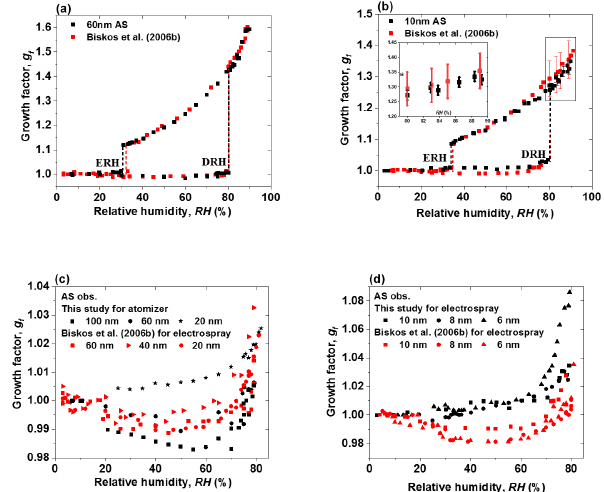
Figure 8. (a–b) Mobility diameter hygroscopic growth factors ( g f ; black squares), deliquescence and efflorescence relative humidity (DRH and ERH; black dashed lines) of ammonium sulfate (AS) nanoparticles with a dry diameter of 60 and 10nm, respectively. Red squares and red dashed lines show the respective results from Biskos et al. (2006b), respectively. Black and red uncertainties of growth factors at certain RH are calculated by the following: (cid:118) (cid:116)(cid:32)(cid:18) (cid:33) √ (cid:117) (cid:19) 2 (cid:16) (cid:17) 2 (cid:117) 2 ε Dp + g f ε RH d g f , where ε Dp , ε RH , and g f are the D p d RH uncertainty of particle mobility diameter, the uncertainty of relative humidity, and the growth factor with respect to RH, respectively (Mochida and Kawamura 2004). (c–d) Comparison of growth fac- tors of ammonium sulfate (AS) nanoparticles with a dry diameter range from 6 to 100nm, with Biskos et al. (2006b) prior to deli- quescence of ammonium sulfate